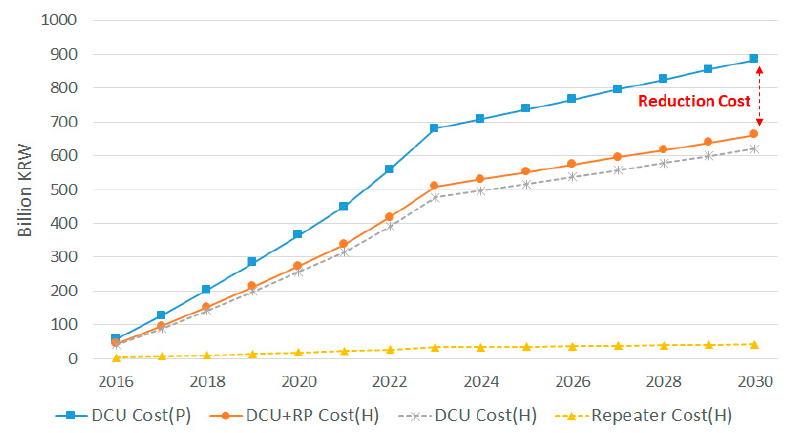
Figure 7. Comparison of DCU and Repeater Cost Results per Deployment Method (P: PLC-Only, H: Hybrid). Table 8. Comparison of DCU and Repeater Cost Results for Hybrid AMI.